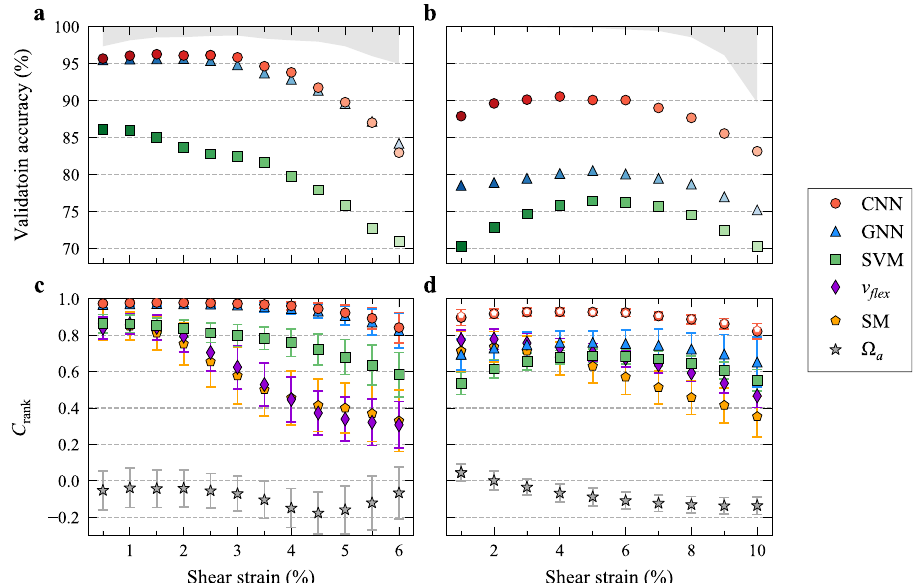
Fig. 3 Predictive power enabled through deep learning. a Accuracy achieved using three different machine-learning methods (CNN, GNN, and SVM) at different shear strains using a constant f thres of 0.5% for 2D L-J glasses. b The corresponding results for 3D Cu 50 Zr 50 glasses. The lower edge of the region shaded gray is the upper bound, i.e., the ceiling predicted using labels based on new D 2 min after conducting another deformation simulation on the same samples belonging to the test dataset (see more details in “ Methods ” ). c The cumulative rank correlation ( C rank , see text for its de fi nition) for the 2D L-J glasses between real local plastic response in a sample along a given loading orientation and the plastic susceptibility predicted via each of the six routes, including the three machine-learning models and the other three based on physical parameters, i.e., fl exibility volume ( v fl ex ), soft modes (SM), and atomic volume ( Ω a ). The corresponding results for the 3D Cu 50 Z 50 glasses are shown in d . The C rank value is the average for 50 (10) different samples loaded in 4 (24) different loading orientations for the 2D (3D) glasses, with the error bar marking the standard deviation. For the 3D glasses, each sample contains 32,000 atoms, although the soft mode analysis was conducted using smaller samples each containing 10,000 atoms. For a fair comparison, CNN was also applied on these smaller samples, as shown with open pentagons (i.e., white pentagons overlapping with red full circles) in d . Here, all species are considered simultaneously, and it has been con fi rmed that all the trends shown here remain the same for the predictive capability reached, when predicting just based on a speci fi c particle type. Supplementary Fig. 15 shows the comparison of the three machine-learning methods for each individual